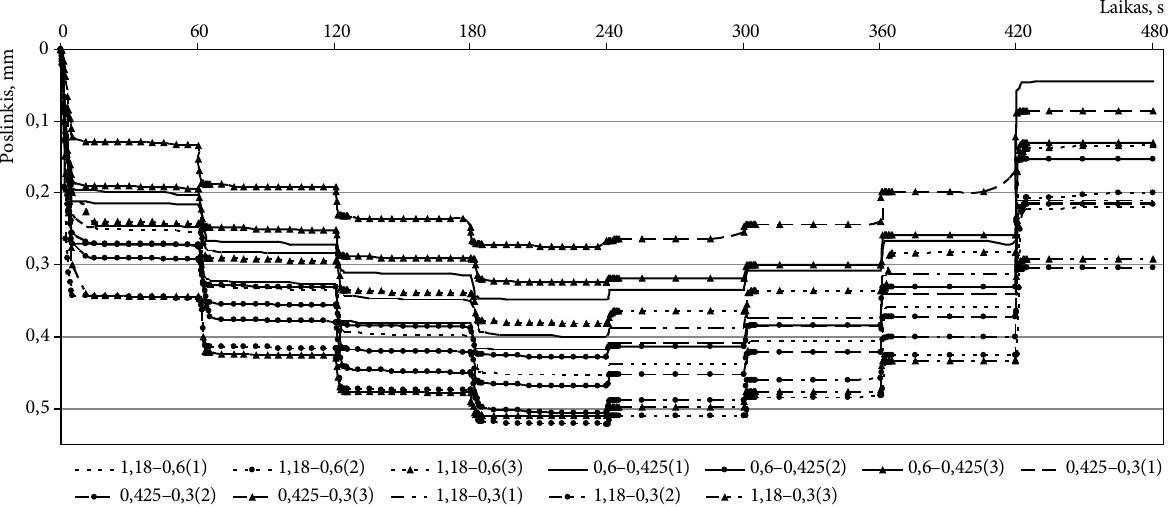
Fig. 6. The dependence of different size fraction (test number) displacement on time and gradually variable load